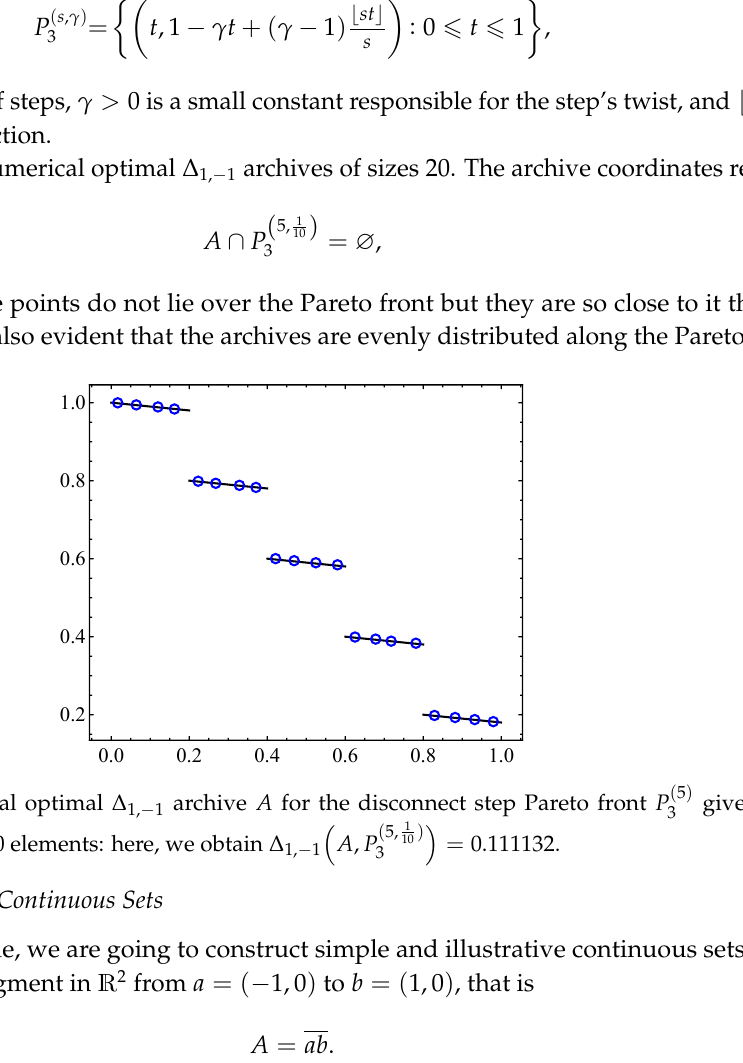
(cid:16) (cid:17) ( 5, 1 ) = 10 A , P 3